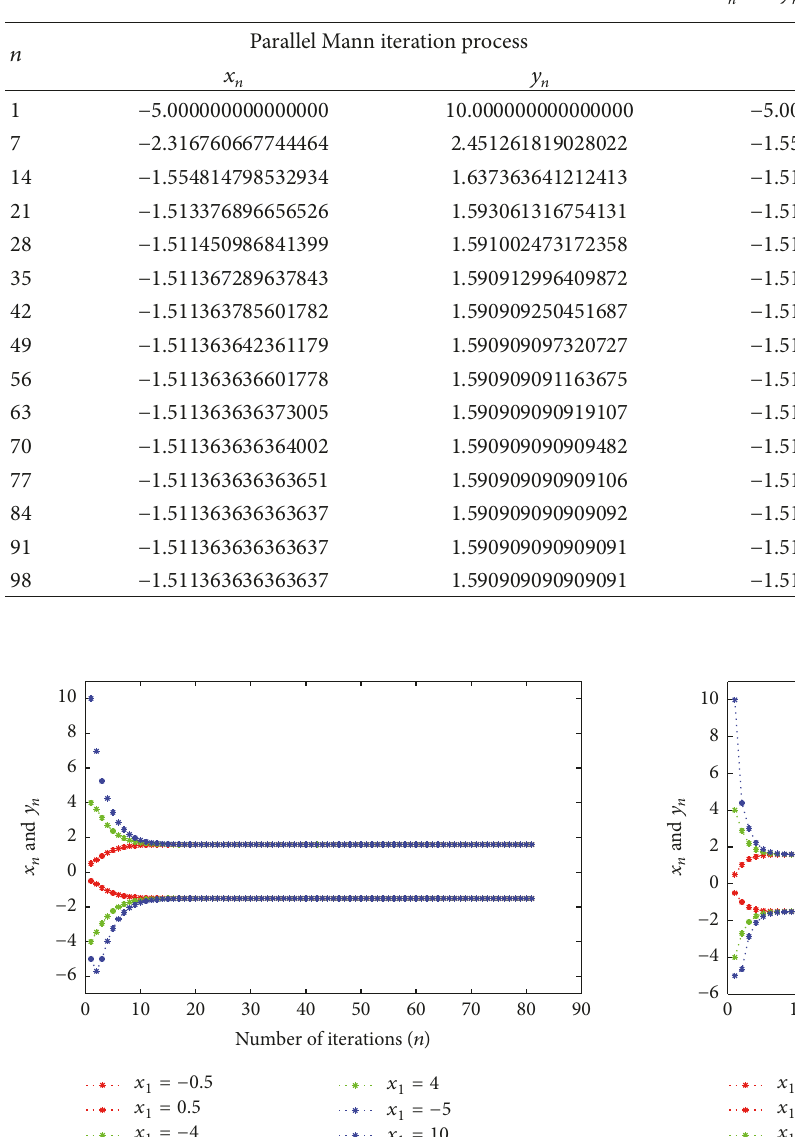
Table 2: Numerical values of 𝑥 𝑛 and 𝑦 𝑛 .